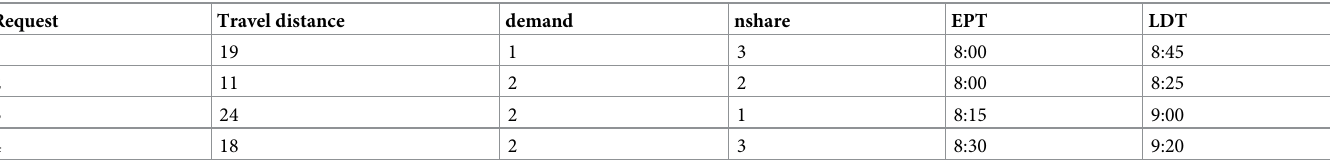
Table 1. Example with 4 requests (configuration).